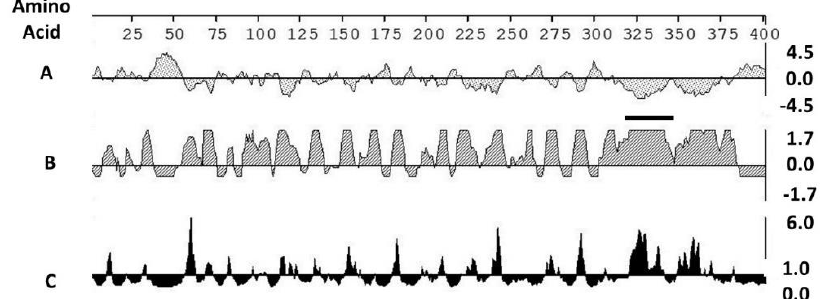
Figure 1. Selection of an immunogenic marker: Evaluation of the antigenicity of the Neospora caninum SRS2 protein by: A . Kyle Doolittle hydropathy plot—a negative value indicates hydrophilic residues; B . Jameson Wolfe antigenicity index; C . Emini surface probability plot. B and C : the height of the vertical bar is proportional to the predicted antigenicity of the sequence. A positive value indicates higher immunogenicity. Horizontal bar: amino acid positions in the sequence selected for analysis. Solid dark line: peptide sequence 324 QSSEKRDGEQVNKGKPP 348 selected as the marker in the vaccine construct.